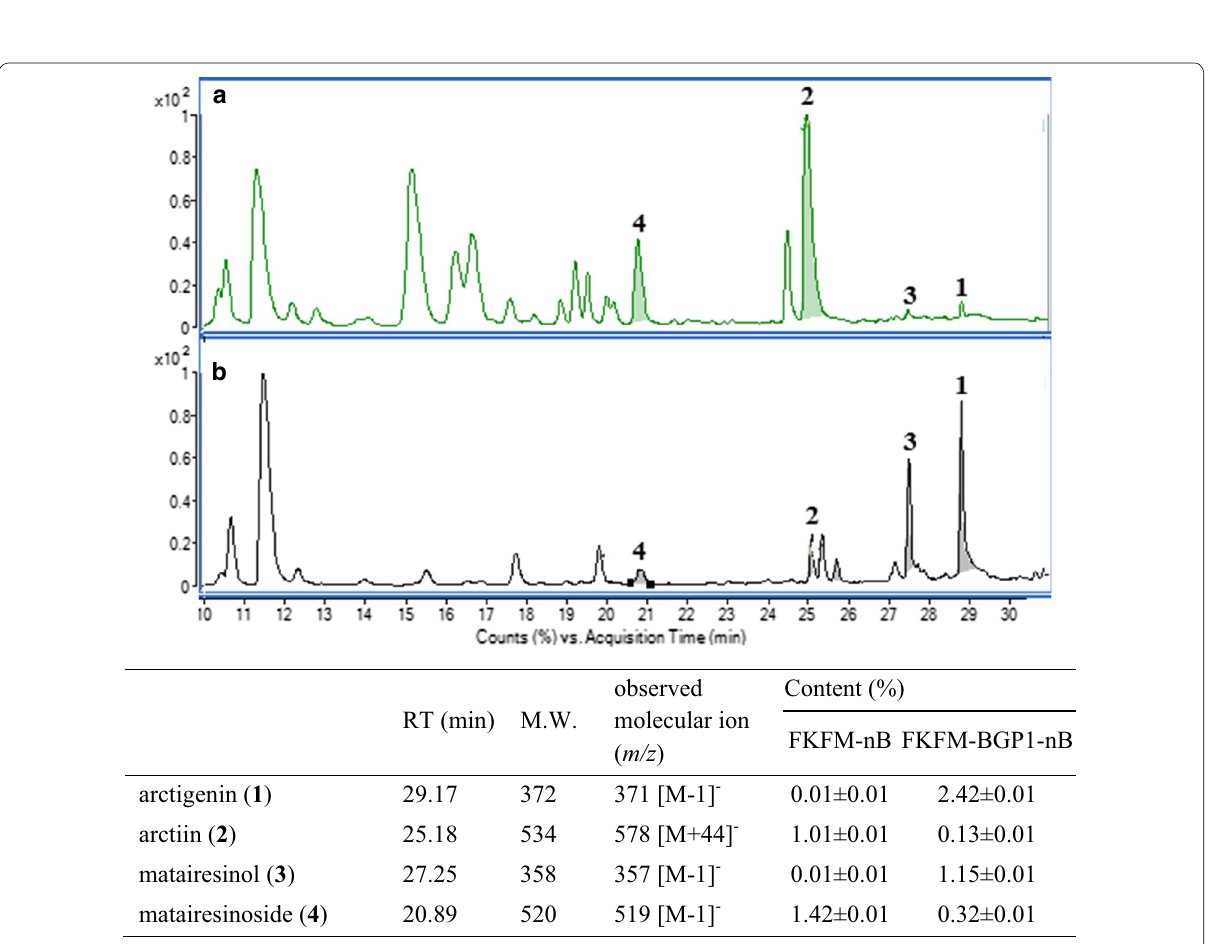
Fig. 4 LC‑ESI–MS chromatograms of compounds 1–4 , n ‑BuOH fraction of Forsythia koreana flowers MeOH extract (FKFM‑nB), and n ‑BuOH fraction of fermented FKFM (FKFM‑BGP1‑nB), and mass spectra in multiple reaction monitoring (MRM) scan mode. FKFM‑nB and FKFM‑BGP‑1‑nB were obtained by extraction of both MEOH extracts using n ‑BuOH. Contents of lignans in FKFM‑nB ( a ) and FKFM‑BGP1‑nB ( b ) from F. koreana flowers were determined based on LC/MS